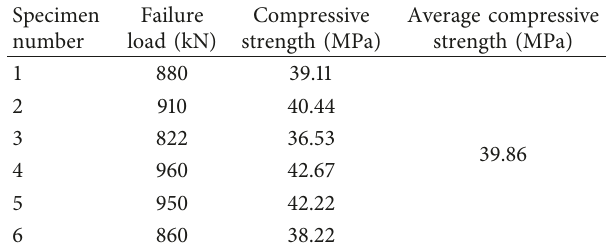
Table 1: Mechanical property of